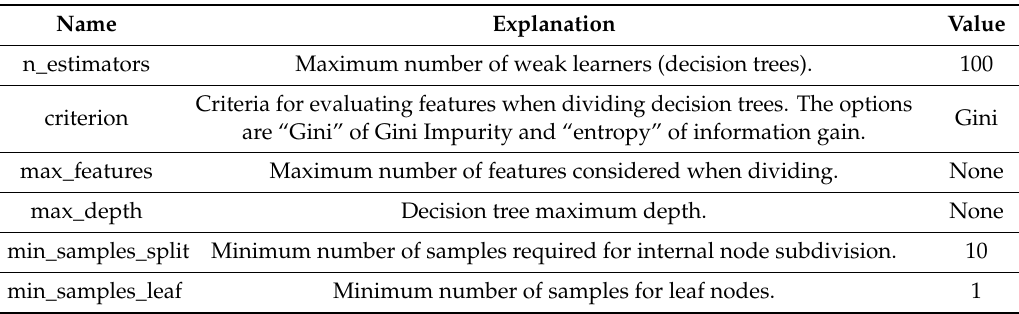
Table 3. Random Forest algorithm parameter setting.